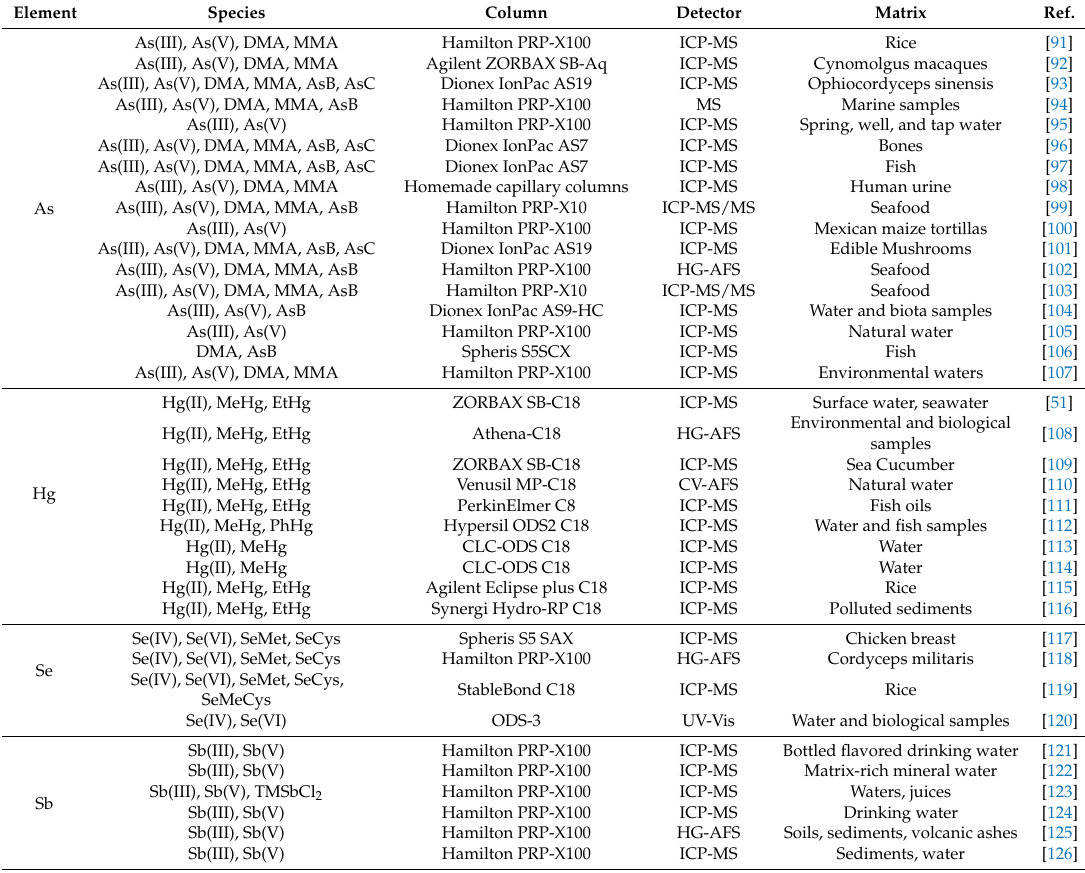
Table 2. Some publications of hyphenated techniques based on LC for the speciation analysis of As, Hg, Sb and Se in environmental and biological samples in recent three